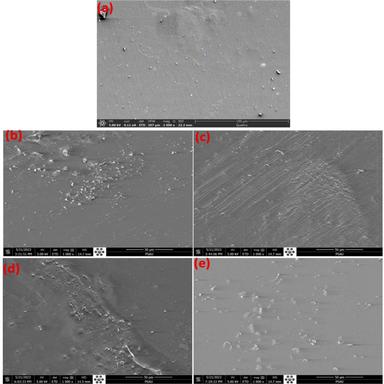
SEM images of (a) polymer PVA, (b) PVA/5%Nd2O3, (c) PVA/10%Nd2O3, (d) PVA/15%Nd2O3, and (e) PVA/20%Nd2O3.